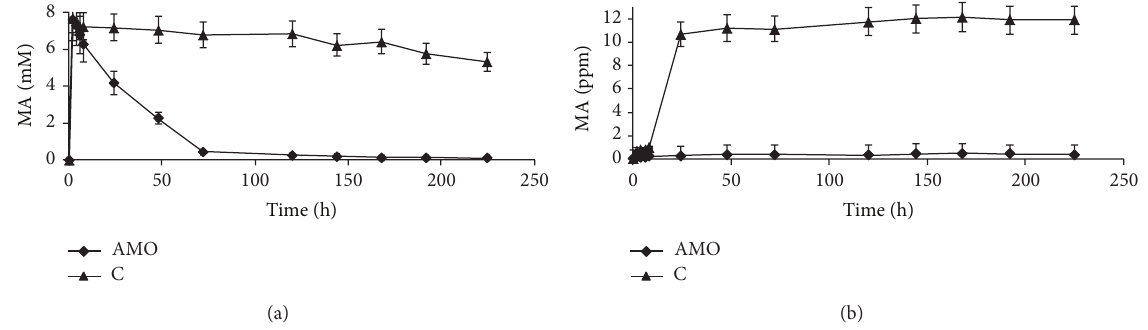
Figure 5: MA concentration in the aqueous (a) and in the gaseous (b) phase of the CFBR upon oxidation of MA in the 7mL min −1 air flow at 100ppm MA inlet concentration by immobilized AMO at the 13.3 Ug −1 CA loading. C (control) blank beads of CA-gel, tested at the same inlet conditions.